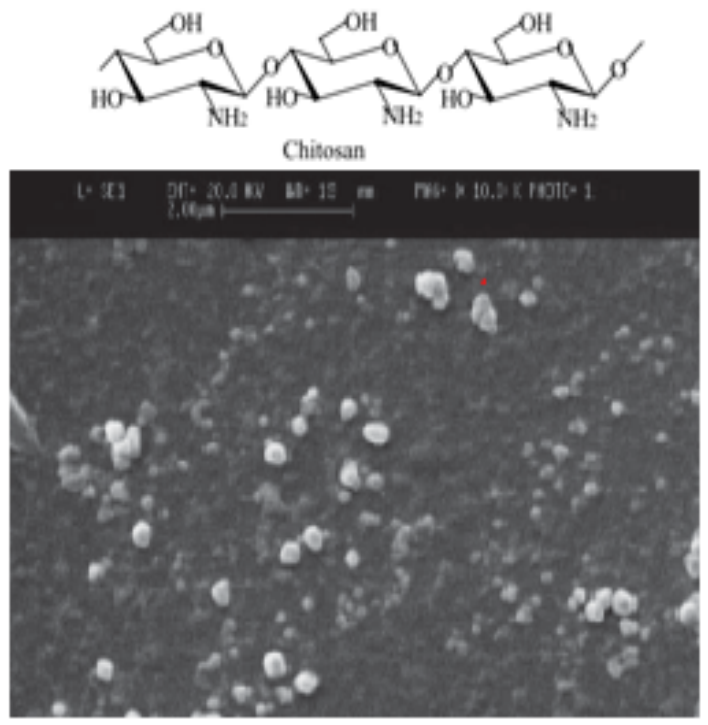
Figure 4. Structure of chitosan and SEM of chitosan nanoparticles [84,85].